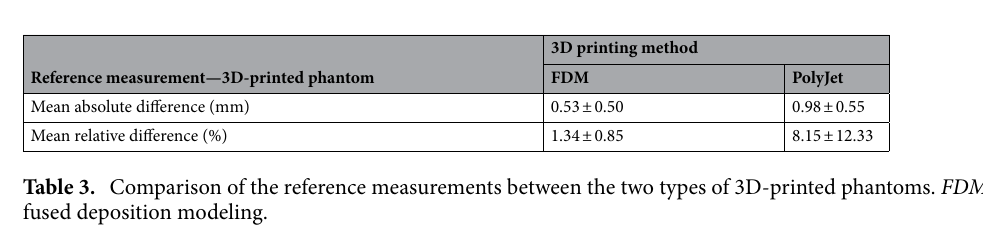
Figure 6. Pediatric thoracic phantom from 3D modeling and made with two types of 3D printers: ( A ) 3D modeling, ( B ) FDM, and ( C ) PolyJet. (3 ‐ matic 12.0, Materialise NV, Leuven, Belgium).